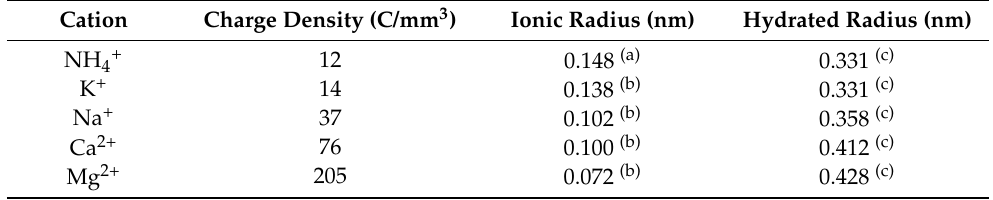
Table 6. Physical characteristics of the investigated